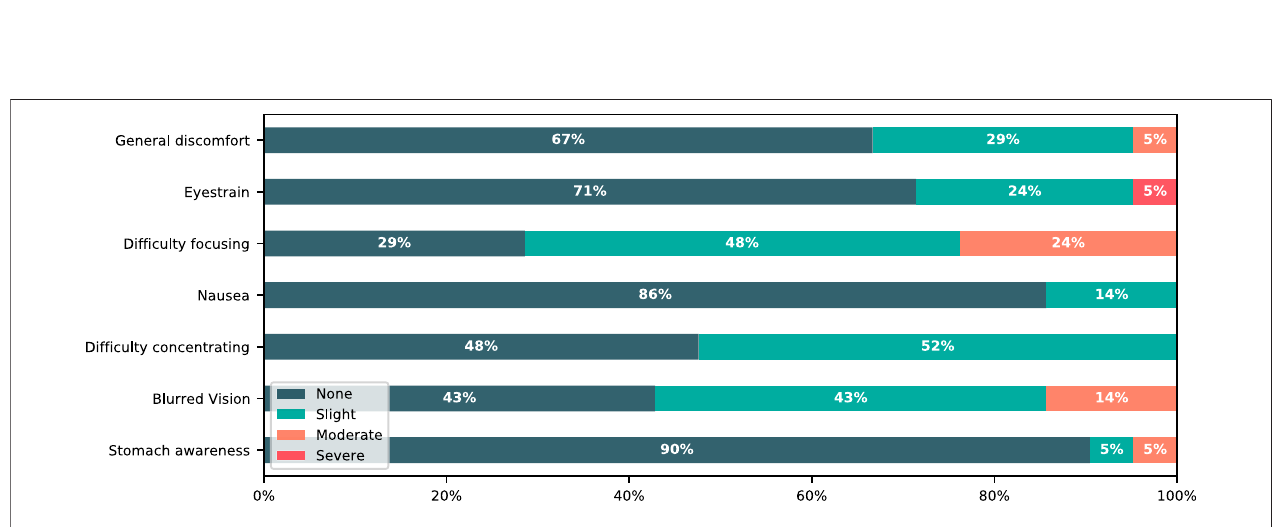
Frontiers in Bioengineering and Biotechnology |